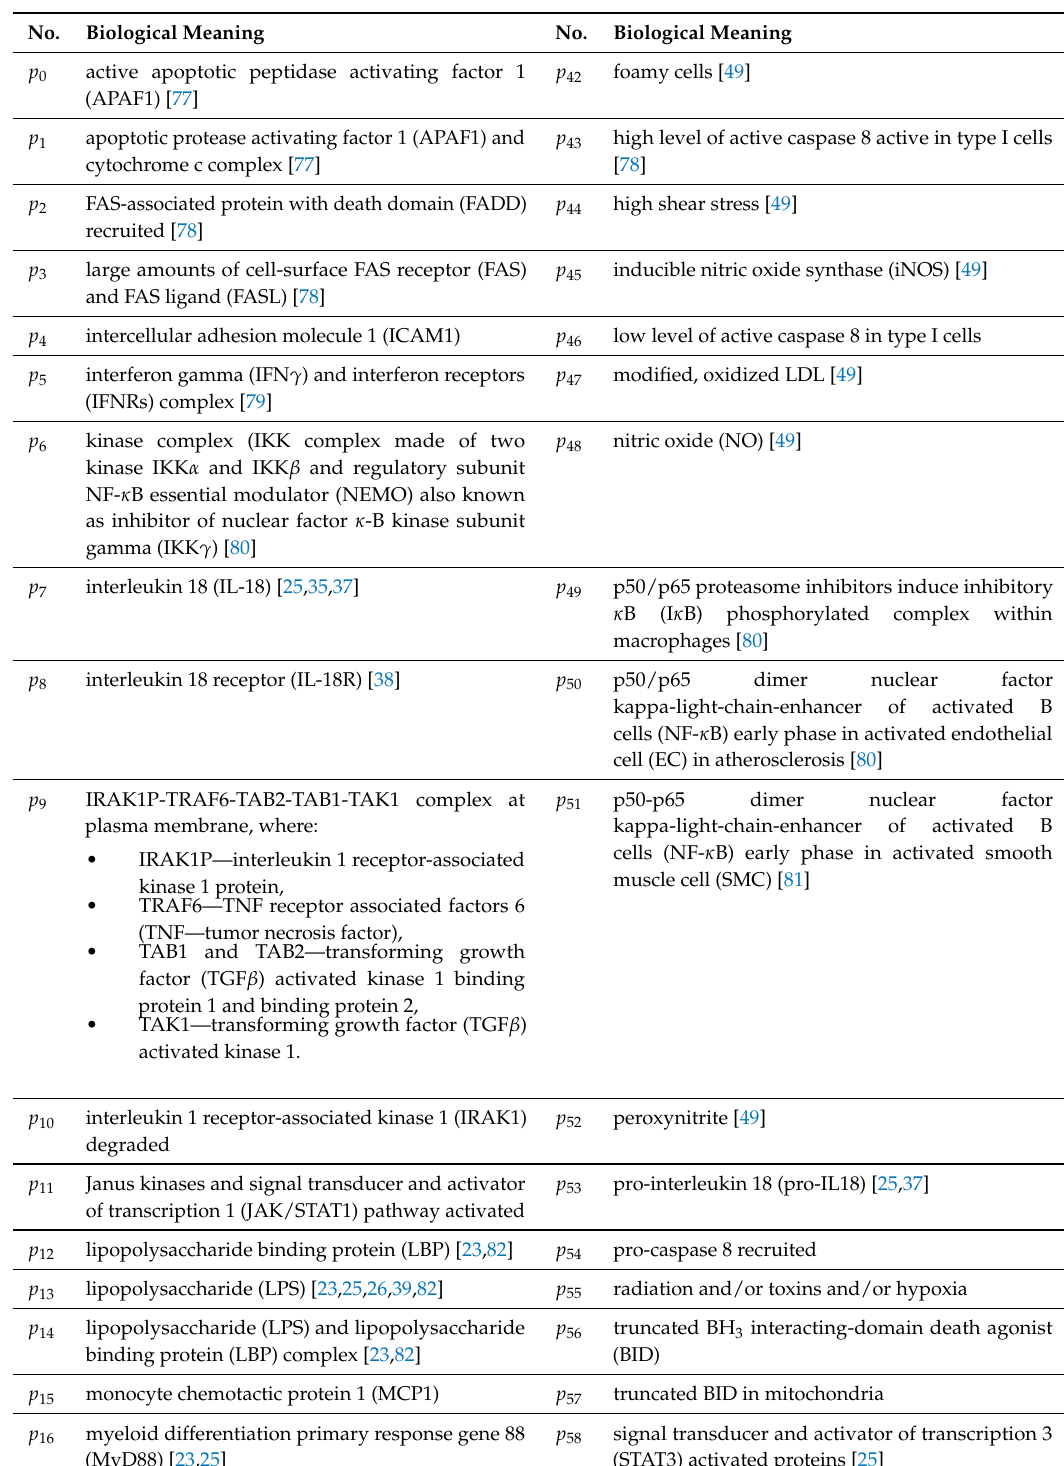
Table A1. List of places. The column “No.” includes the names of places and the column “Biological meaning” includes the names of biological or chemical components corresponding to